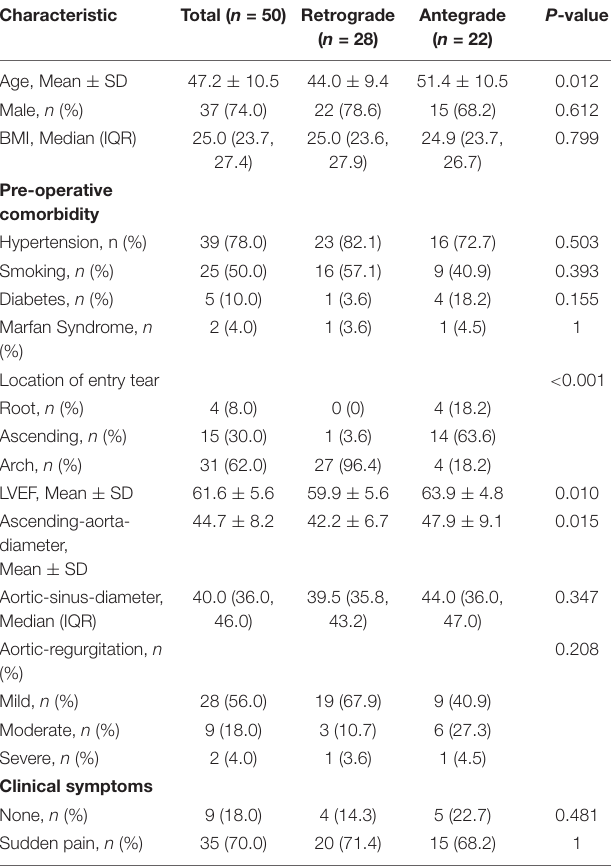
TABLE 1 | Baseline characteristics of participants.